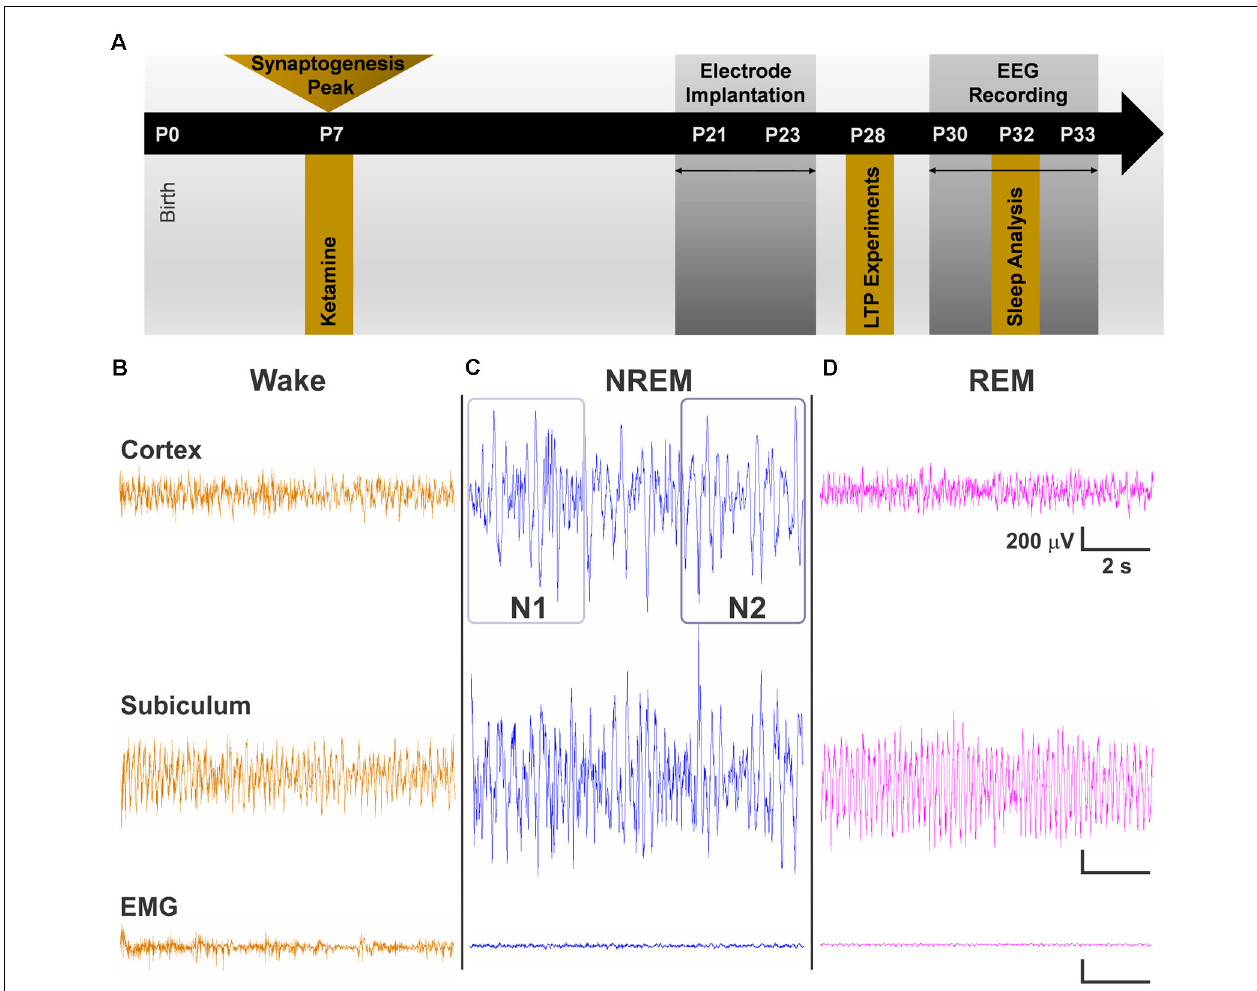
FIGURE 1 | (A) Schematic representation of the timeline of events for the experiment. Exposure to a 12-h regimen of ketamine 40 mg/kg occurred at P7 during peak synaptogenesis. A subset of animals was used for long-term potentiation (LTP) experiments at P28. The other subset were weaned from their mothers between P21 and P23. Electroencephalogram (EEG) recordings began at P30 after rats recovered from surgery, and data were obtained from day 3 of recordings at P32. (B–D) Representative traces of cortical EEG, subicular local field potential (LFP), and of electromyography (EMG) signals used alongside time-locked videos to score sleep. (B) Traces during wake represent an animal that was freely and actively moving as noted by its high-frequency EMG. (C) Representative traces during non-rapid eye movement sleep (NREM) show low frequency cortical oscillations and minimal movement in EMG. N1 and N2 were distinguished by differences in the predominance of delta oscillations, with delta comprising >50% epoch in N2. (D) Cortical oscillations during REM are similar to those of the Wake stage but with a nearly flat line in the